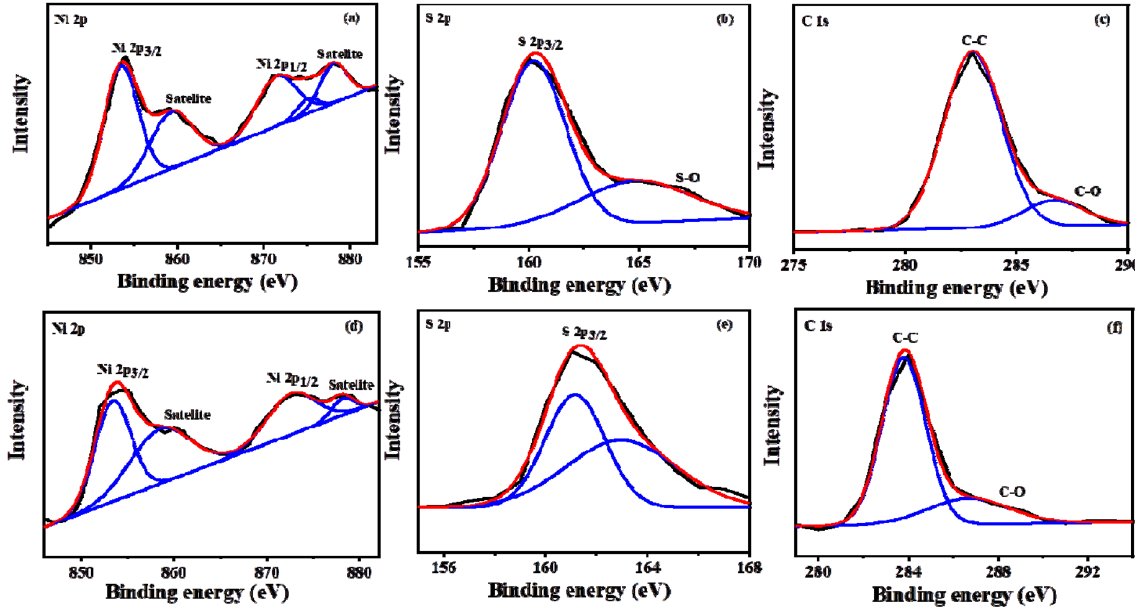
Figure 5. XPS core level spectra of NISE-1 ( a – c ) and NISO ( d – f ) samples for Ni 2p, S 2p and